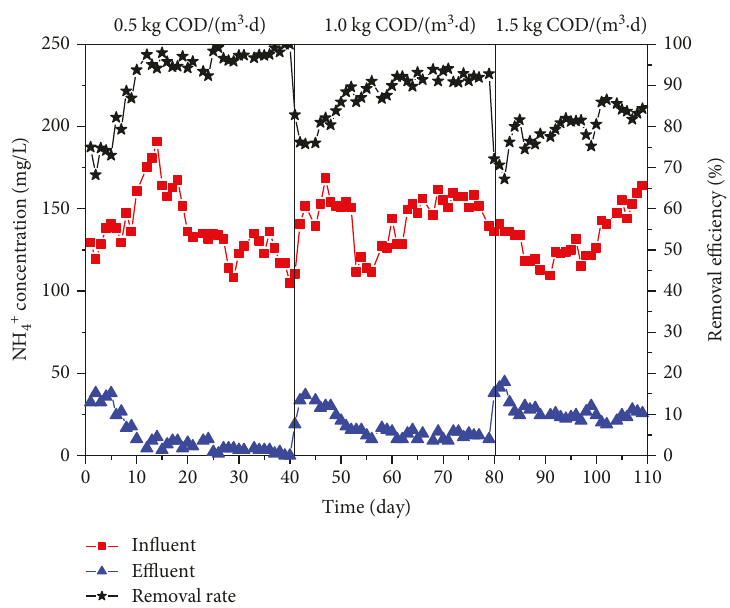
Figure 3: NH 4+ -N concentration variations in in fl uent and e ffl